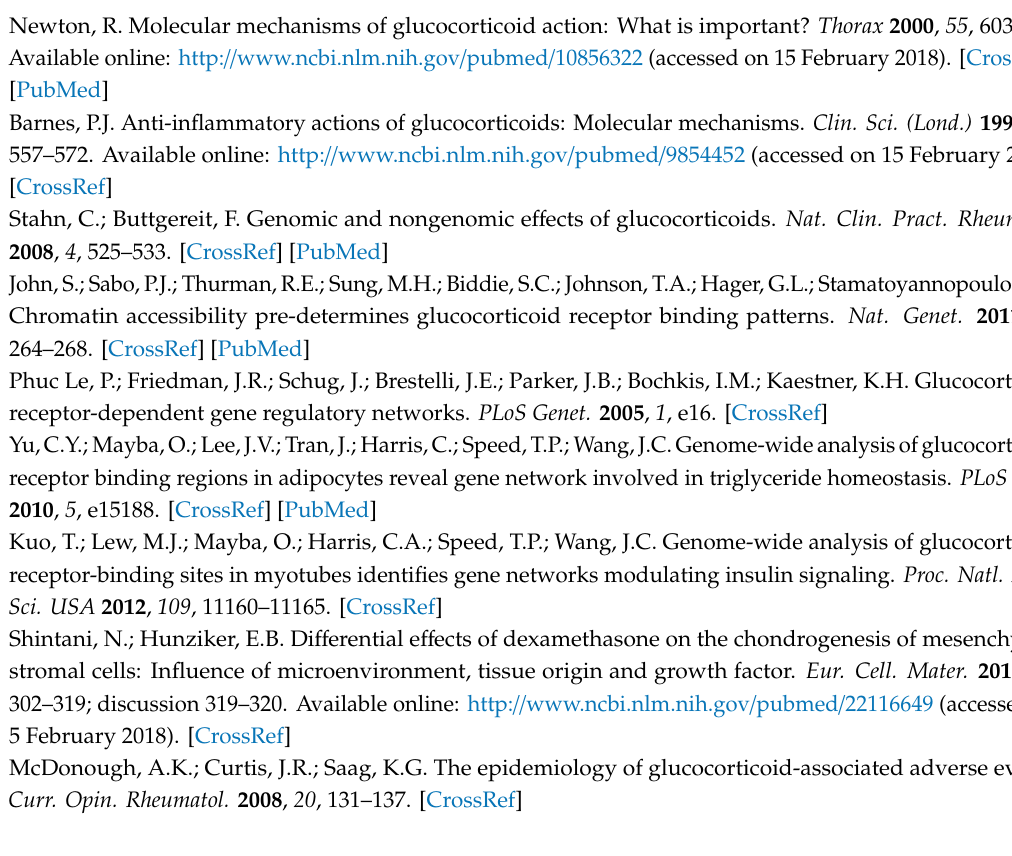
s1. Table S1. List of di ff erentially expressed significant proteins, with the fold change and p -values, identified in di ff erent organs between Dex-treated versus control SD rats using a label-free quantitative LC-MS / MS approach. Table S2 . Table showing the abbreviations (gene name) and full name for all proteins mentioned in Table 1. Table S3 : Table showing the top three molecular and cellular functional categories significantly altered in each organ after long-term Dex treatment with their p -value range, number of molecules involved, and the gene names of the involved proteins. Table S4: Table showing the IPA identified canonical pathways altered by Dex treatment. Figure S1 . Network analysis of all the di ff erentially expressed proteins identified in the di ff erent organs between the Dex-treated and control rats. The network identifies an integrated pathway that demonstrates the overall e ff ect of prolonged dexamethasone in the treatment versus the control rats with the network related to drug metabolism, endocrine system development and function, and biochemistry with the score of